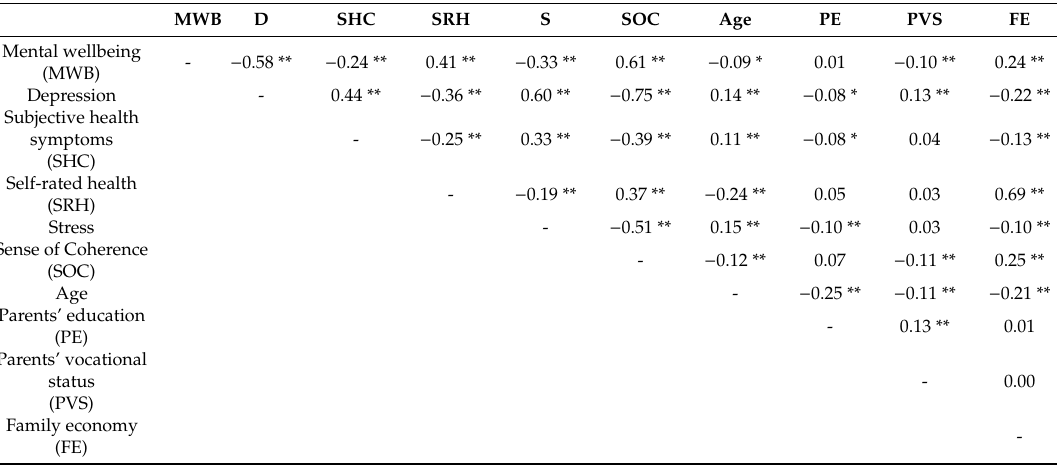
Table 3. Correlations between the study